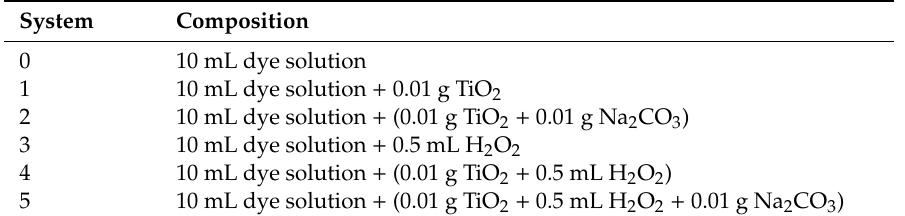
Table 1. Composition of the initial systems subjected to a photocatalytic test; Concentrations of the